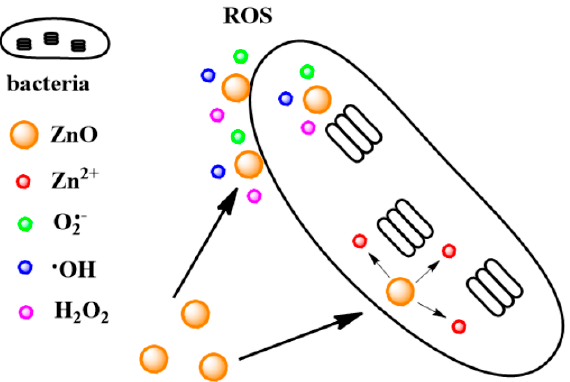
Figure 12. Schematic illustration of antibacterial activity of ZnO NPs. In the outer cell membrane of the bacteria, an excess of reactive oxygen species (ROS) is expected and a release of Zn 2+ ions, which in high concentration are cytotoxic. Reprinted from Zhang, Z.Y., and Xiong, H.M., Photoluminescent ZnO Nanoparticles and Their Biological Applications, Materials 2015 , 8(6), 3101-3127; DOI: 10.3390/ma8063101, under the CC BY 4.0 license.